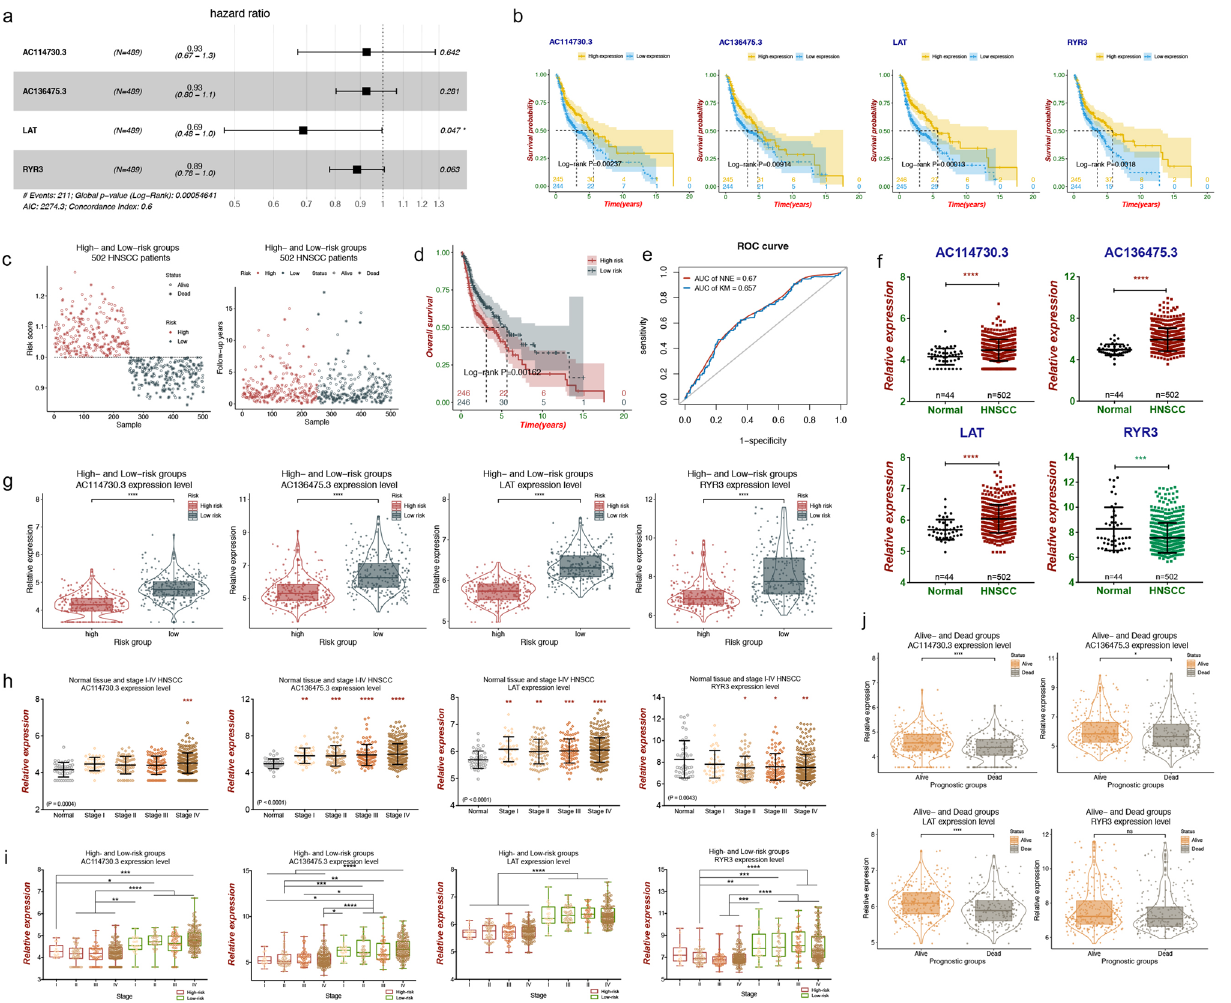
Figure 7. HNSCC-specific prognostic risk model and validation. ( a ) The prognostic model including 2 lncRNAs and 2 mRNAs. ( b ) Kaplan–Meier survival curves for 2 lncRNAs and 2 mRNAs associated with OS of HNSCC patients by Log-rank test. X axis represented overall survival time (years) and Y axis represented survival probability. ( c ) The HNSCC patients were divided into high- and low-risk groups based on the risk scores of HNSCC patients. ( d ) Survival analysis suggested high risk group had worse prognosis in HNSCC patients. ( e ) The ROC analysis showed the AUC of the prognostic model was 0.67 and 0.657 that were calculated by NNE and KM method, respectively. ( f ) Expression patterns of the 2 lncRNAs and 2 mRNAs between HNSCC samples and normal samples. ( g ) Violin plots of expression patterns between high-risk group and low-risk group. ( h ) Comparison of expression levels for 2 lncRNAs and 2 mRNAs between normal samples and stage I, II, III, and IV HNSCC samples. ( i ) Comparison of expression levels for 2 lncRNAs and 2 mRNAs at different clinical stages between high-risk and low-risk groups. ( j ) Violin plots of expression patterns between alive and dead patients. *: P < 0.05; **: P < 0.01; ***: P < 0.001; ****: P <